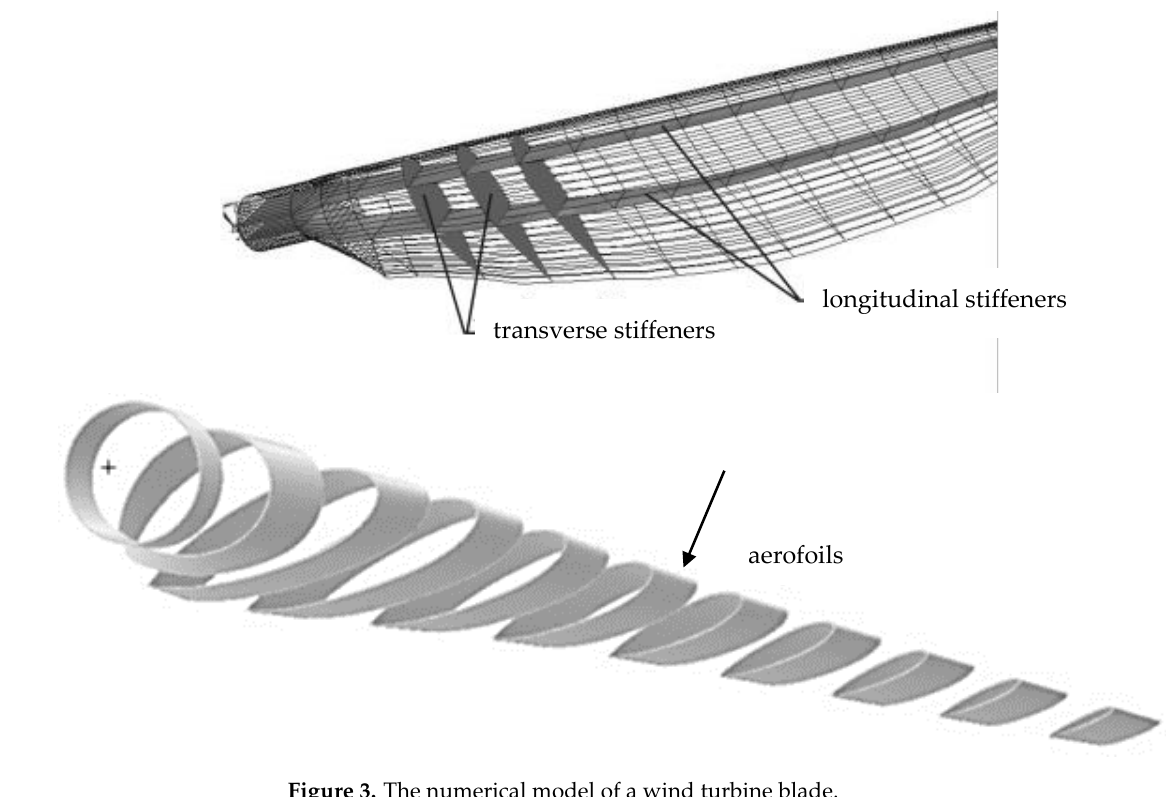
Figure 3. The numerical model of a wind turbine blade.